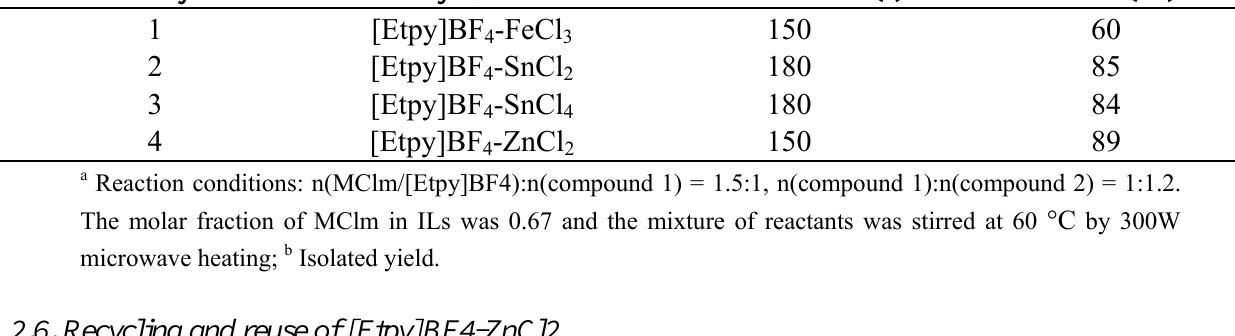
Figure 3. Recyclability of the [Etpy]BF